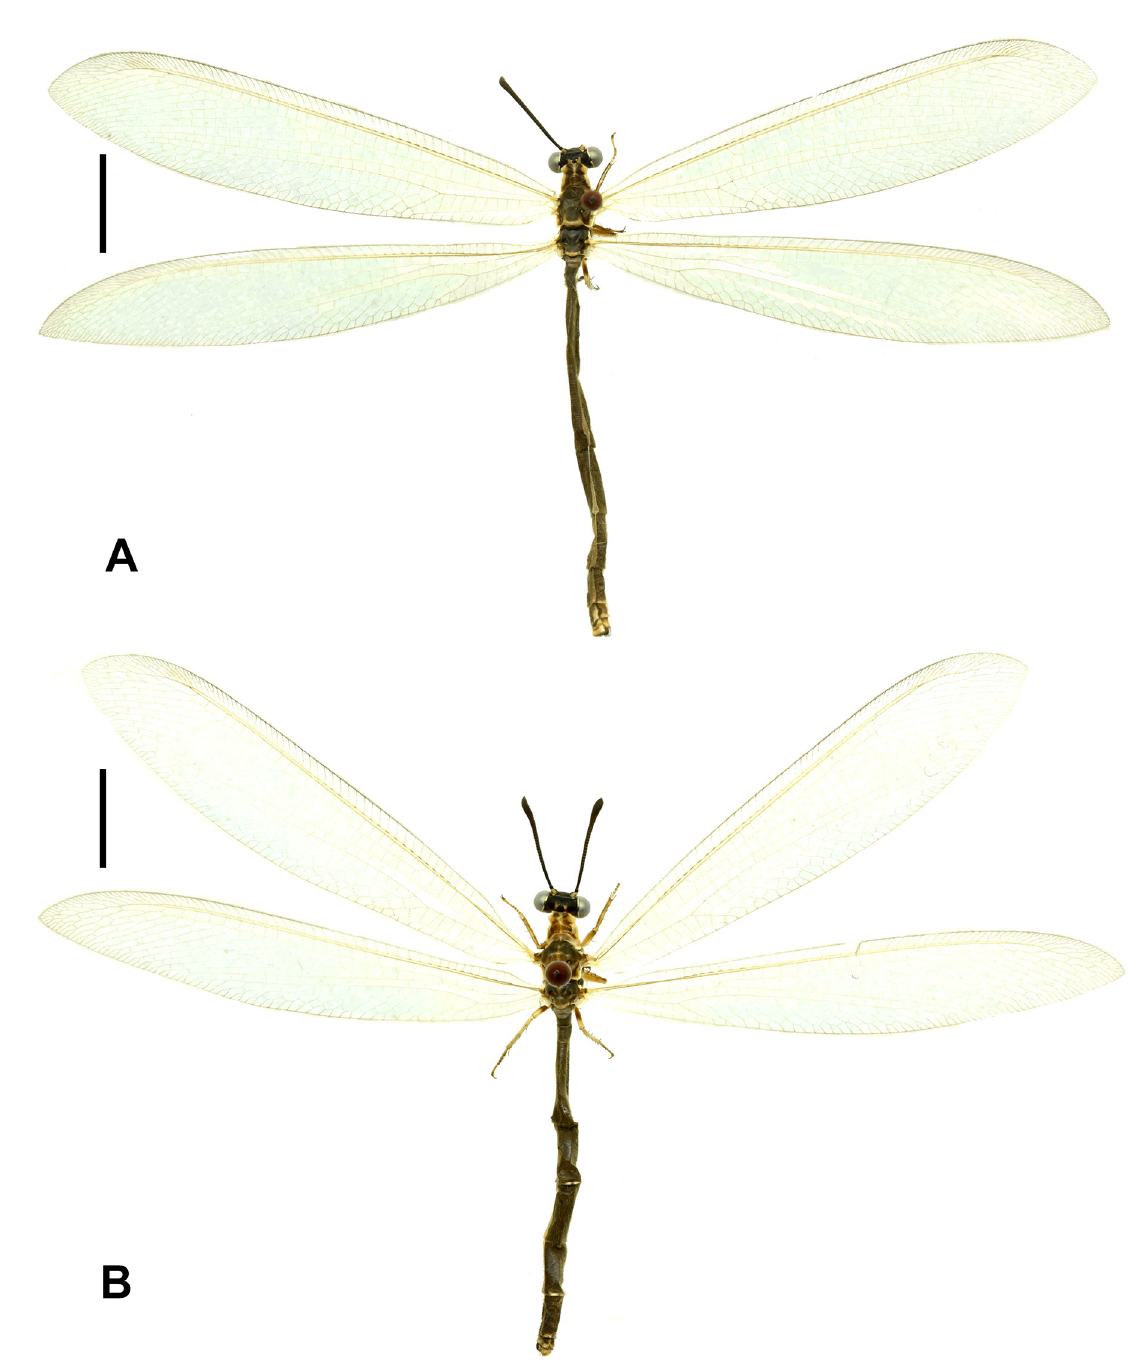
Fig. 6. Myrmeleon tenuipennis Rambur, 1842. Dorsal habitus. A . Male (CAUPK000010). B . Female (CAUPK000011). Scale bars = 5.0